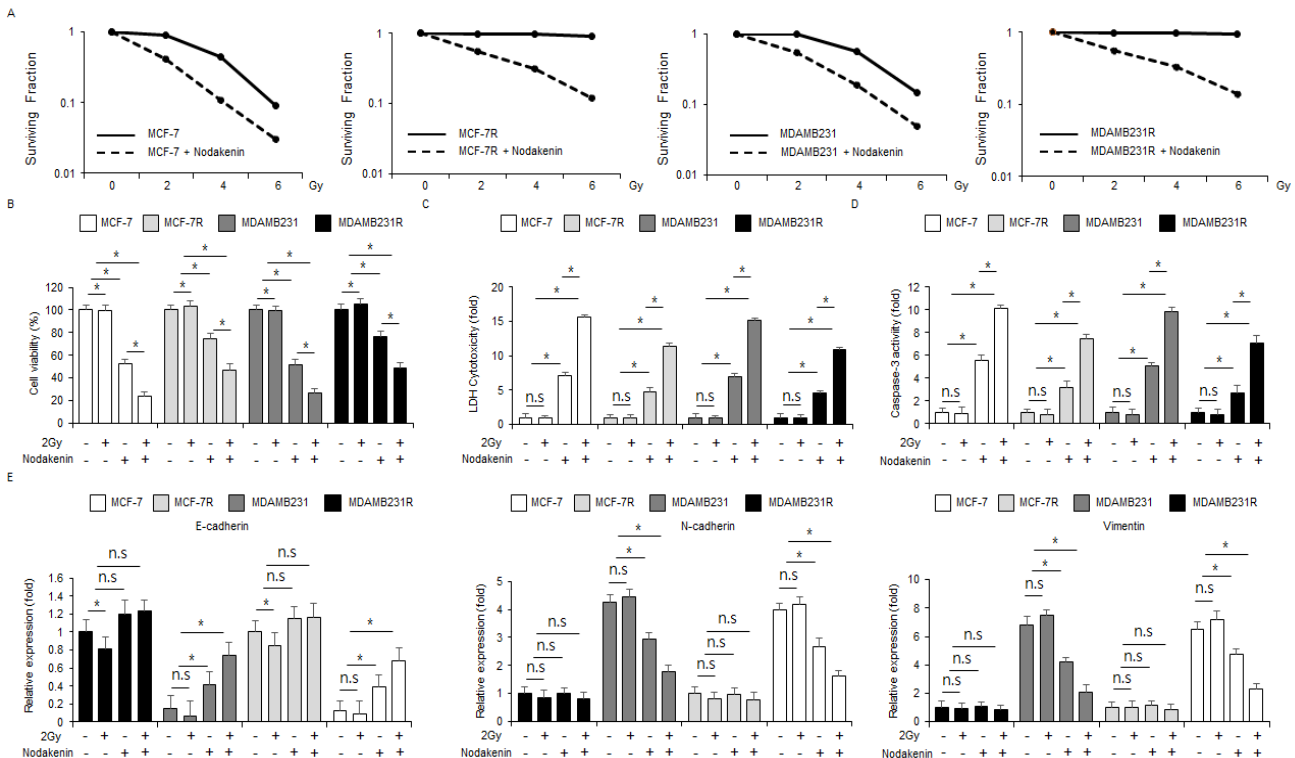
Figure 8. Radiation in combination with nodakenin overcomes resistance in radioresistant breast cancer models. ( A ) A colony formation assay was carried out at the indicated doses (0, 2, 4, and 6 Gy) of radiation in combination with nodakenin (40 μM), and then the survival fraction was calculated in MCF-7, MCF-7R, MDAMB231, and MDAMB231R; * p < 0.05. ( B – E ) MCF-7, MCF-7R, MDAMB231, and MDAMB231R cells were co-treated with nodakenin (40 μM, 24 h) and radiation (2 Gy, 24 h). LDH, WST-1, and caspase-3 activity assays were carried out along with a real-time qRT-PCR for the mRNA expression levels of E-cadherin, vimentin, and N-cadherin; * p < 0.05. n.s., not significant. β -actin was used as the mRNA loading control. Real-time RT-PCR was confirmed in at least three independent experiments.